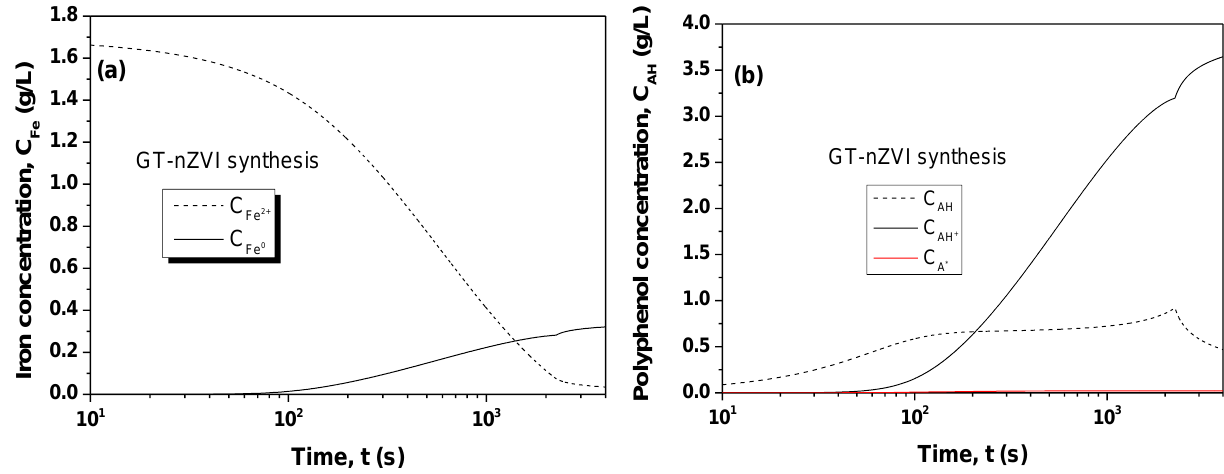
Figure 12. Numerically predicted transient responses of the concentration of (a) iron species, (b) polyphenol species, during the GT-nZVI